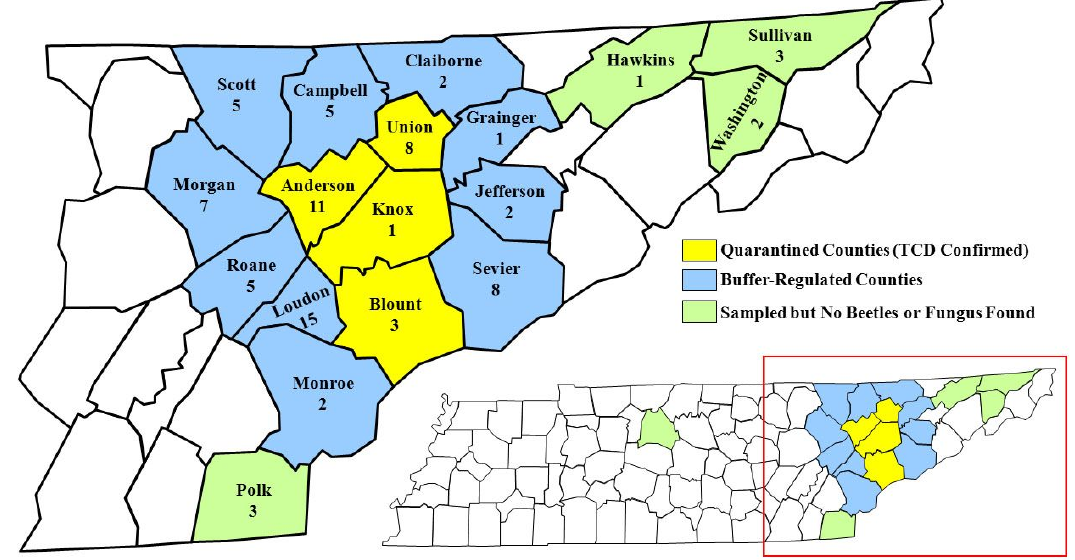
Figure 3. Distribution of known locations of thousand cankers disease (TCD) in eastern Tennessee, 2010. TCD was confirmed if both walnut twig beetle and G. morbida were present. Counties where TCD has been confirmed are quarantined; adjacent counties are designated as buffer counties and are also regulated. Numbers represent samples processed in each county; two samples were processed from Davidson Co. in middle Tennessee